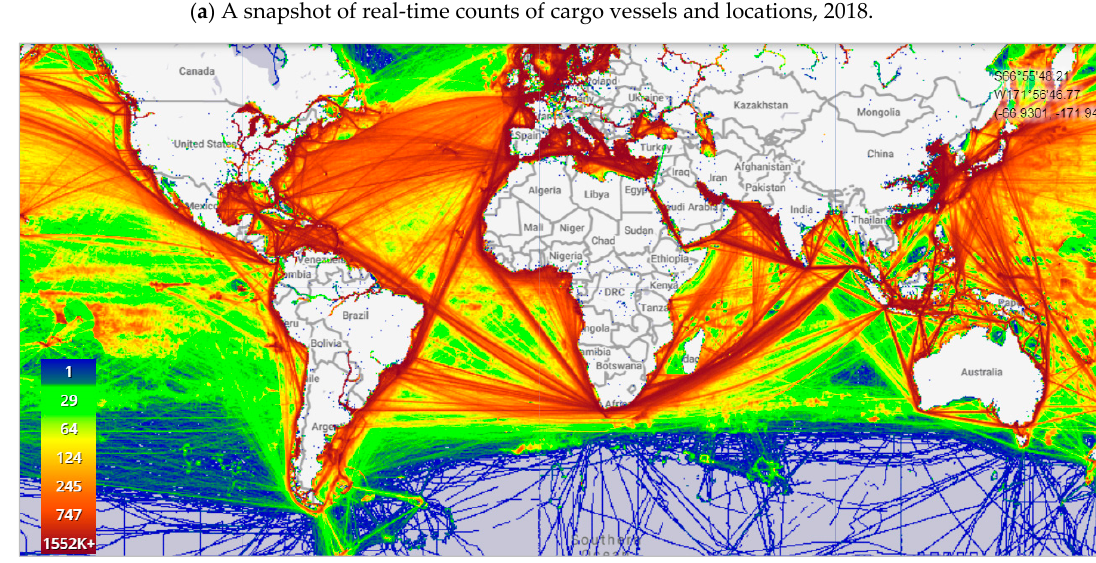
Figure 11. Real-time cargo vessels and density maritime networks, 2018.